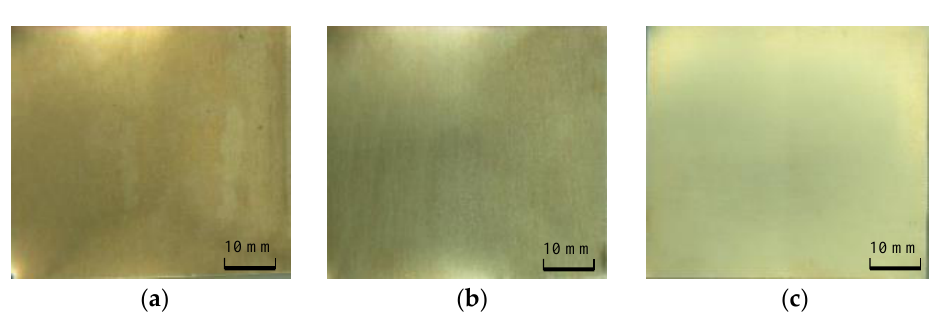
Figure 3. Images of beryllium bronze sheet: ( a ) original, ( b ) polished, ( c ) and cleaned. (4) Pasting photo-sensory membrane.